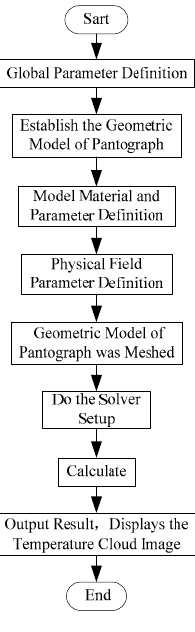
Figure 1. Simulation solution flow of the pantograph arc.